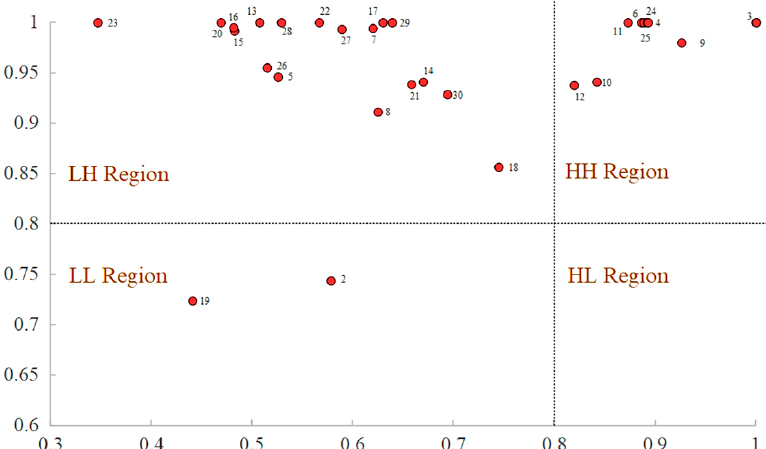
Figure 4. Distribution of average efficiency of knowledge and technology